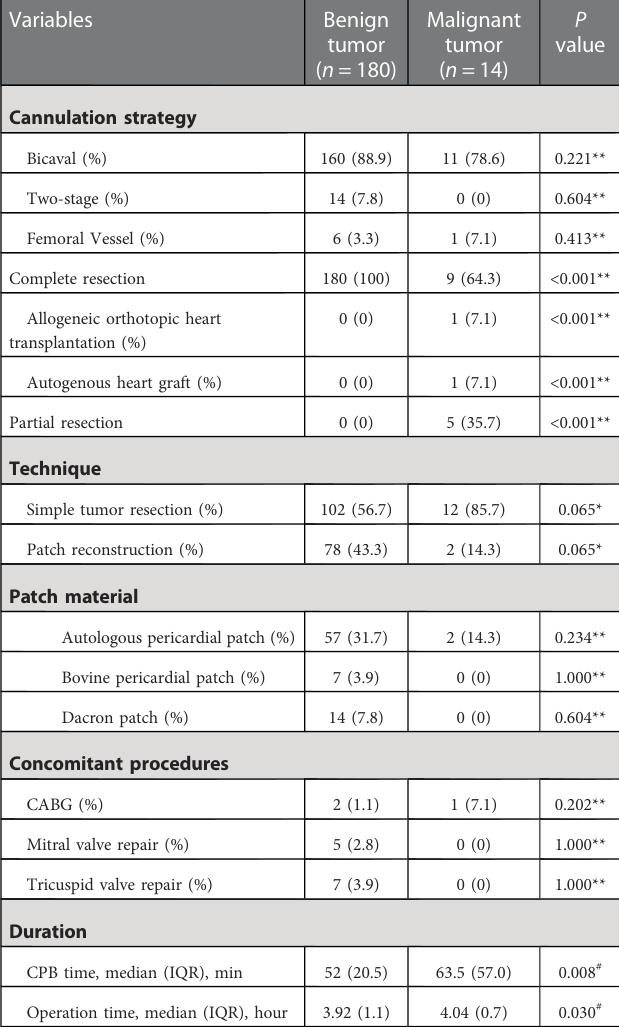
TABLE 4 Operation characteristics of primary atrial tumor